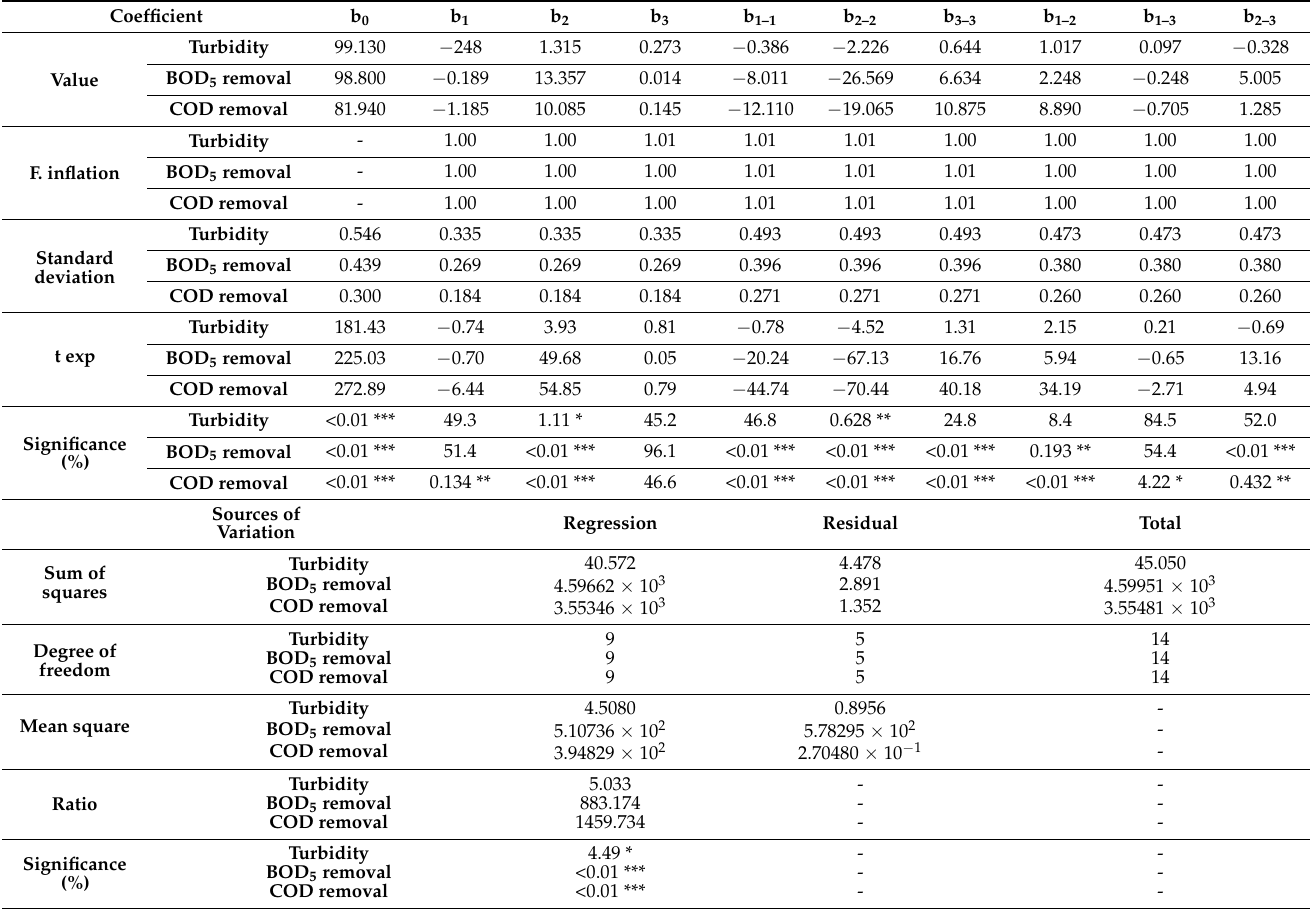
Table 6. Analysis of variance (NemrodW) for the FW treatment